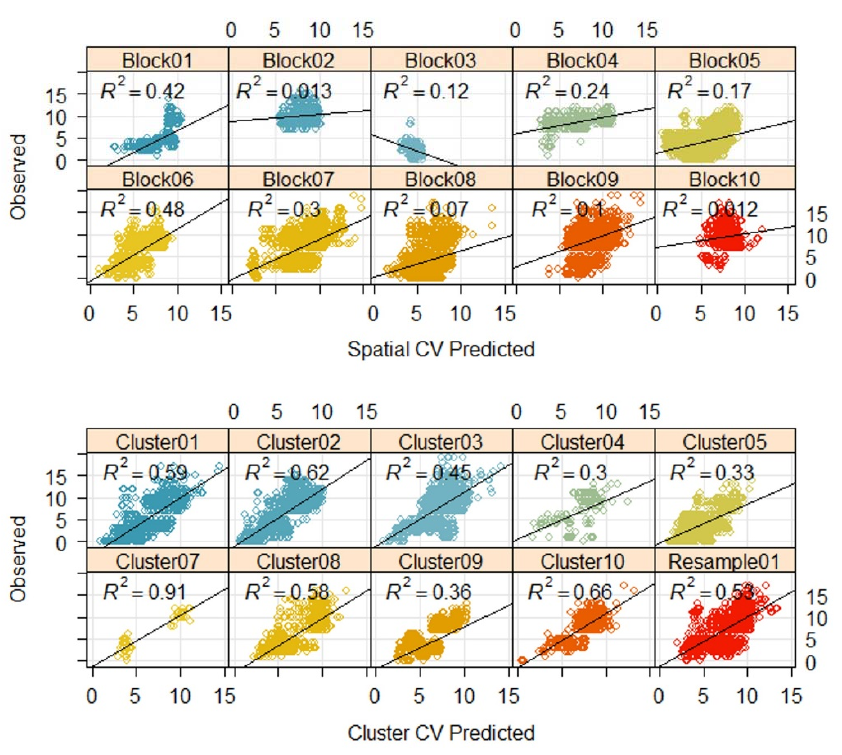
Figure A7. Random fold (top), spatial block (middle), and cluster block (bottom) resampling pre- diction performance during CV. The model uses the information included in the nine folds/blocks/clusters to predict the remaining fold/block/cluster.